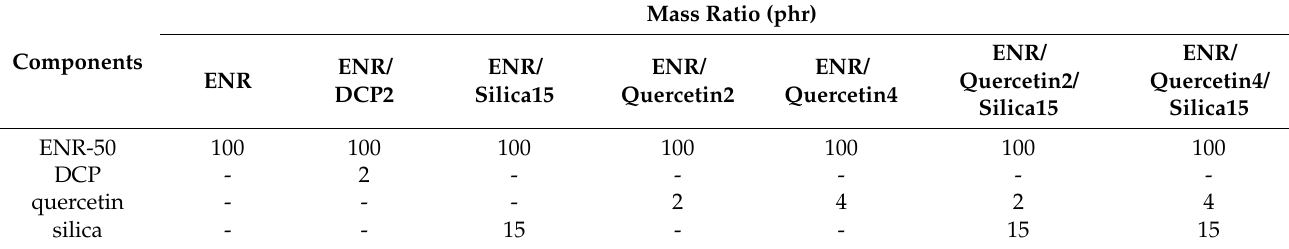
Table 1. Compositions of studied ENR-50-based